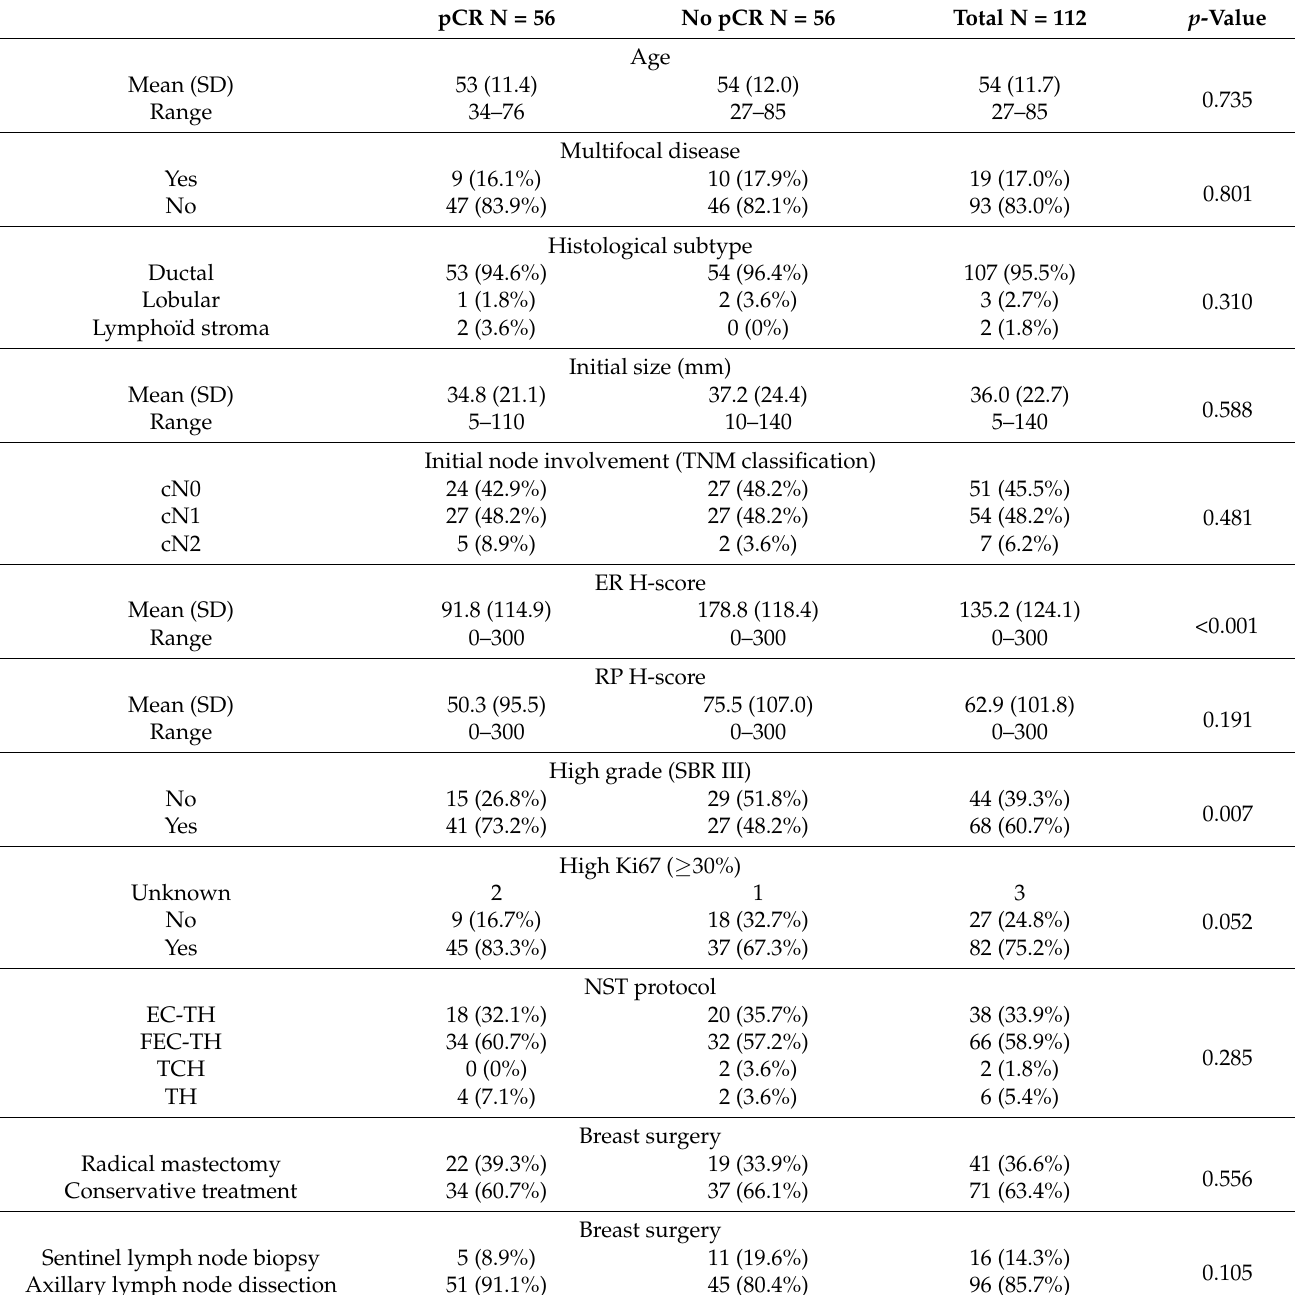
Table 1. Cohort description according to